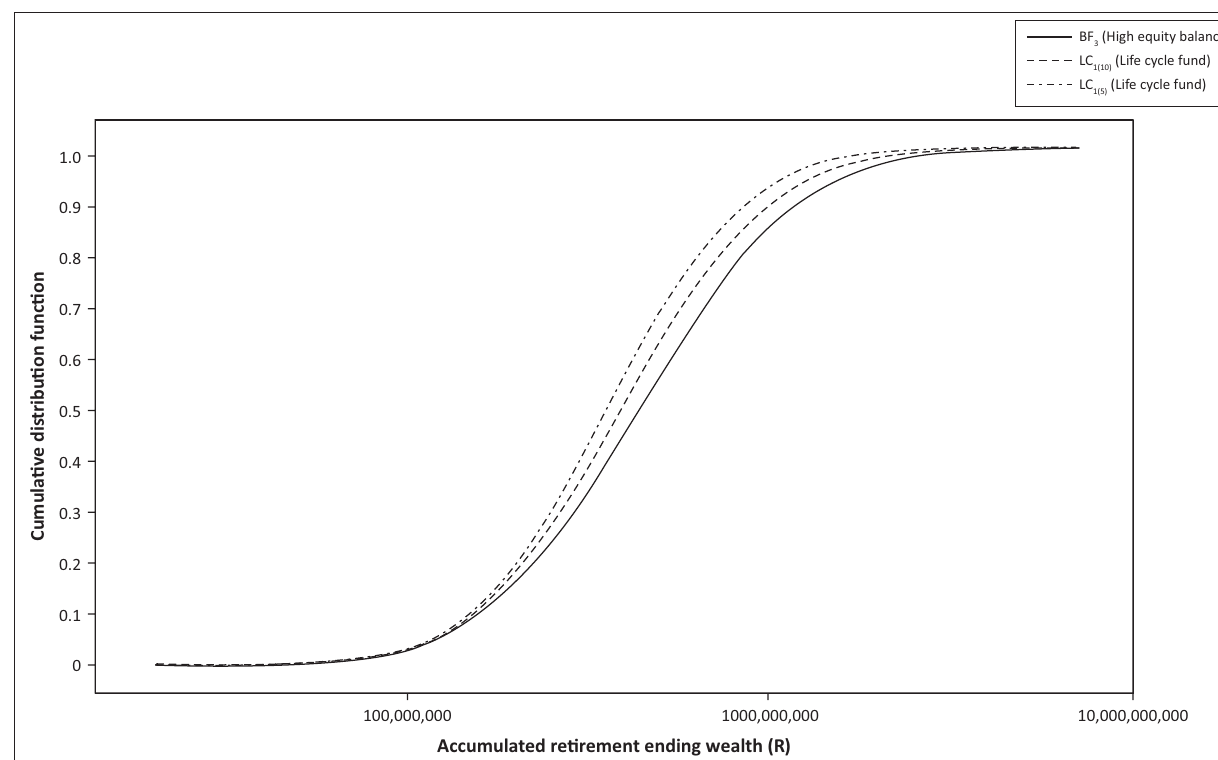
FIGURE 1: Cumulative distribution functions of accumulated retirement ending wealth for models LC